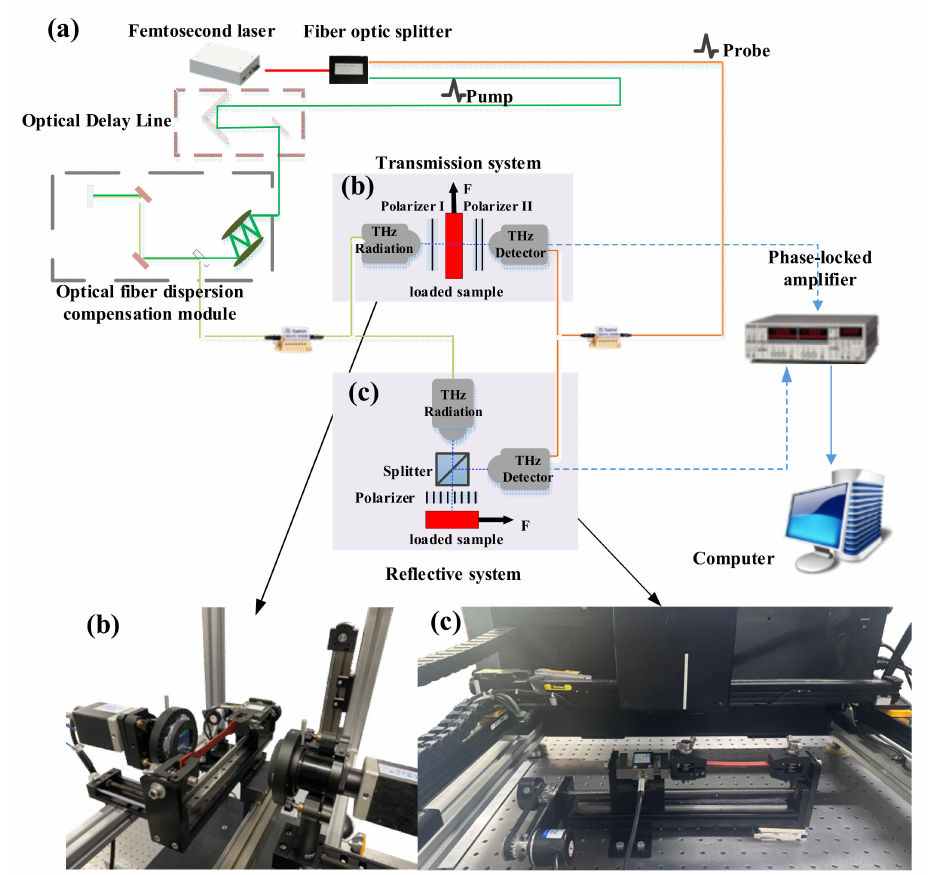
Figure 1. Experimental installation for the measurement of the stress optical coefficient ( a ) Optical path diagram of stress measurement system; ( b ) Transmission measurement system; ( c ) Reflective measurement